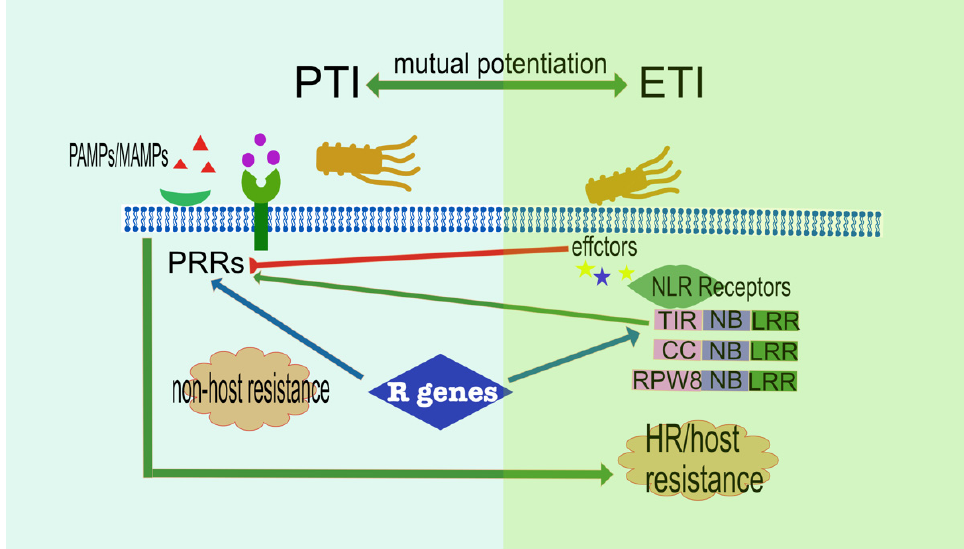
Figure 1. Schematic view of two-tiered immune system of plants. PTI is triggered when surface- localised and transmembrane receptors (PRRs) recognise PAMPs/MAMPs. ETI is triggered when intracellular receptors (NLR receptors) recognise the specific effectors released by pathogens. Effectors hinder the PRRs’ recognition to evade PTI (indicated by red flat arrow). PTI and ETI present mutual potentiation (indicated by green arrows), with the activation of surface receptors in PTI enhancing hypersensitive response (HR) in ETI and the signalling of TNL (TIR-NB-LRR) receptor augmenting PTI through upregulated response induced by PTI elicitor such as flg20/nlp20. R genes encode receptors important in the immune system (indicated by blue arrows).